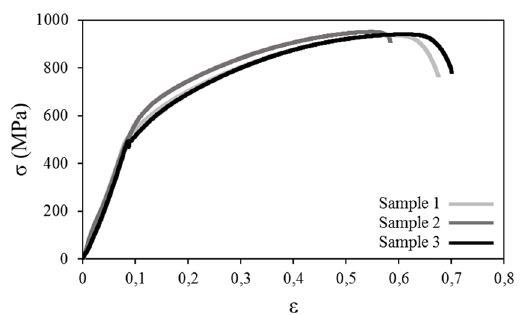
Figure 2 . Tension-deformation curve obtained by the standardized